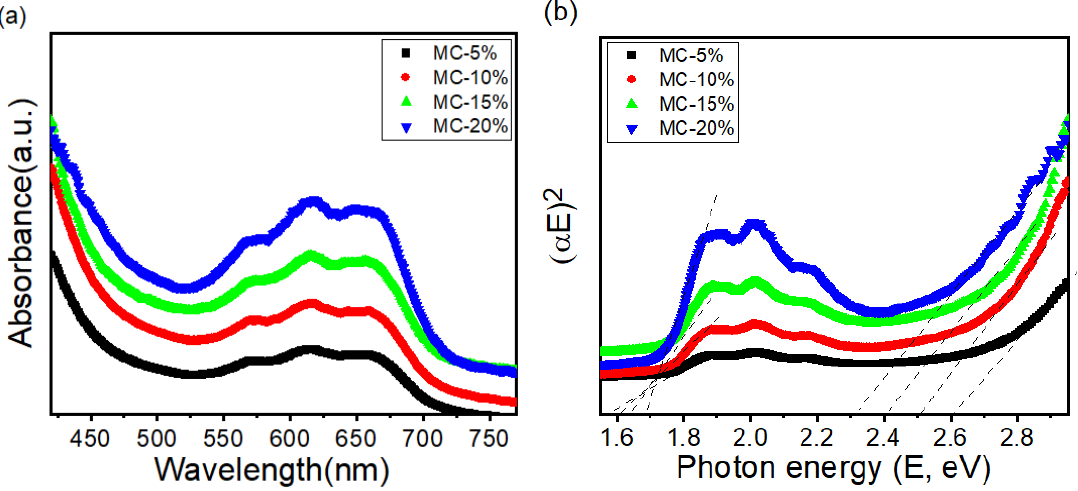
Figure 3. ( a ) UV–vis DRS absorption spectrum and ( b ) Tauc plots of as-prepared nanocomposites.